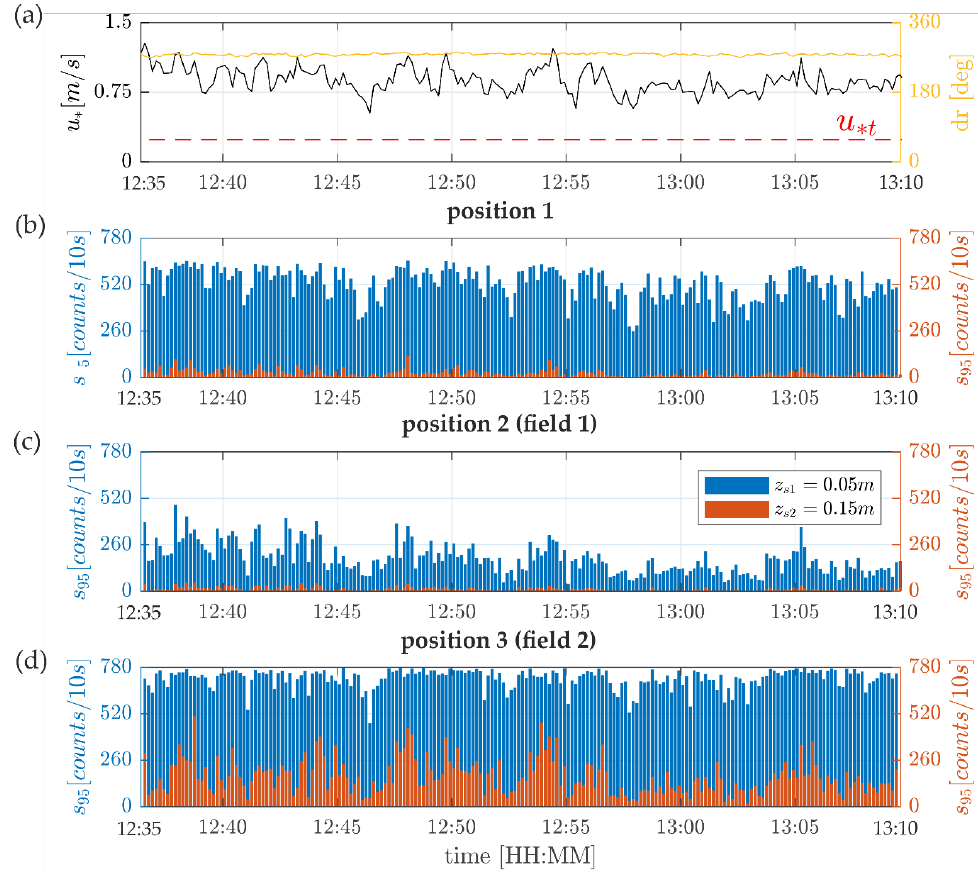
Figure 12. Time series of the ( a ) shear velocity, critical shear velocity, mean wind direction , and ( b , c , d ) 95% quantiles of saltation impacts over 10-s time intervals for the measurement location of the beach